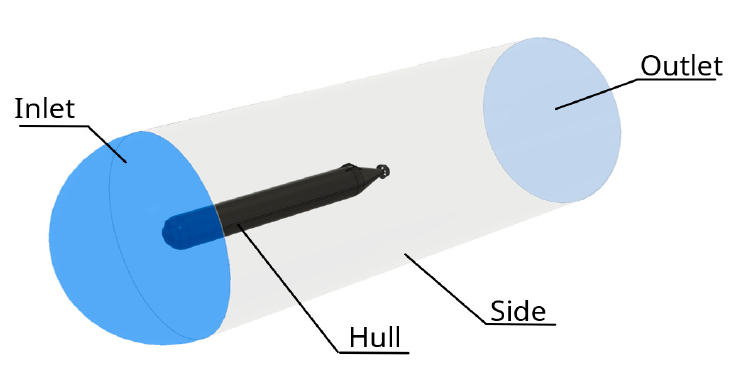
Figure 5. Isometric view of the computational domain with indicated boundary names.